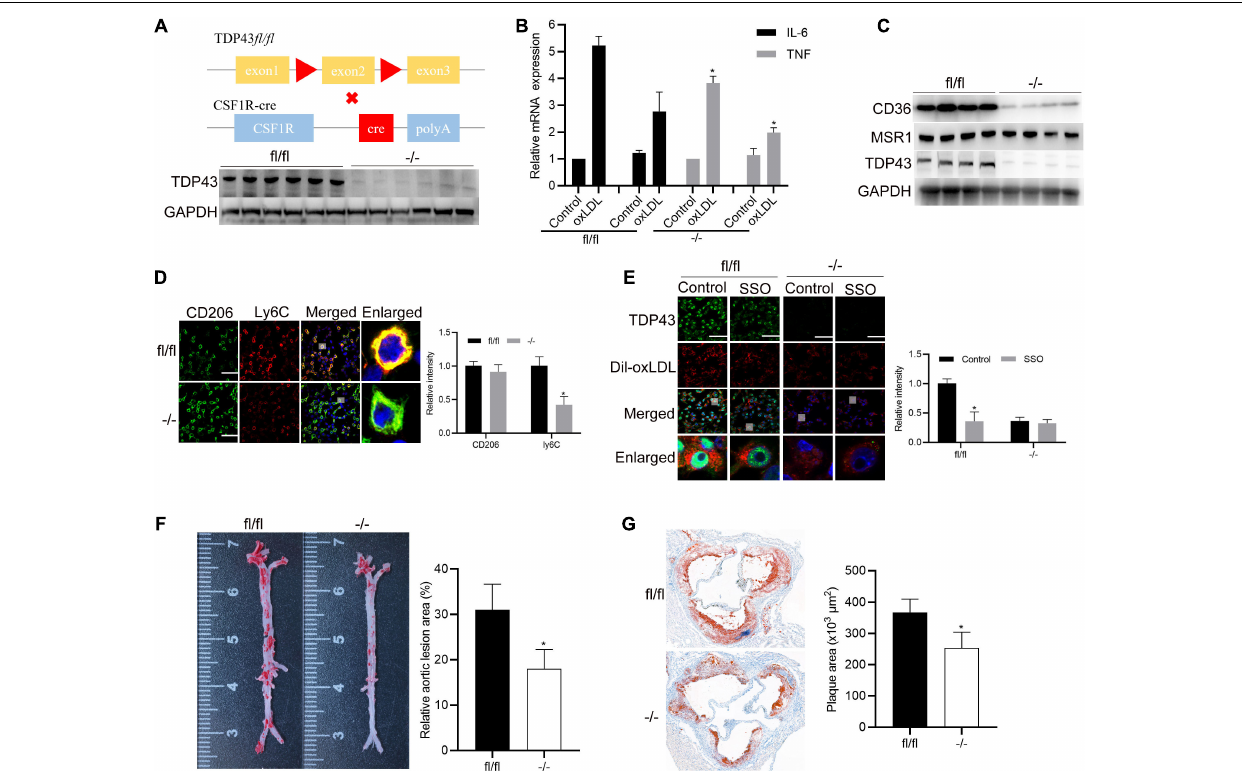
FIGURE 7 | Specific knockout of TDP43 in macrophages alleviates AS progression in vivo . (A) Schematic of macrophage specific TDP43 loss-of-function mouse model (upper panel). Western blot analysis TDP43 from thioglycolate-elicited primary peritoneal macrophages extracts from control (fl/fl) or macrophage-specific TDP43 knockout mice (–/–). GAPDH was used as loading control (down panel). (B) qPCR detection of IL-6 and TNF mRNA expressions in thioglycolate-elicited primary peritoneal macrophages from control (fl/fl) or macrophage-specific TDP43 knockout mice (–/–) with or without oxLDL incubation for 24 h. Data are represented as means ± SD ( n = 3; * P < 0.05 vs. oxLDL fl/fl group). (C) Western blot analysis of CD36 and MSR1 protein expressions in thioglycolate-elicited primary peritoneal macrophages from control (fl/fl) or macrophage-specific TDP43 knockout mice (–/–) from western diet-induced atherosclerotic model. (D) Immunofluorescence analysis of CD206 and Ly6C in thioglycolate-elicited primary peritoneal macrophages from control (fl/fl) or macrophage-specific TDP43 knockout mice (–/–) from western diet-induced atherosclerotic model. Data are represented as means ± SD ( n = 50; * P < 0.05 vs. fl/fl group). Scale bar = 100 µ m. (E) Immunofluorescence analysis of Dil-oxLDL uptake of thioglycolate-elicited primary peritoneal macrophages from control (fl/fl) or macrophage-specific TDP43 knockout mice (–/–) with or without SSO treatment. Data are represented as means ± SD ( n = 50; * P < 0.05 vs. control fl/fl group). Scale bar = 100 µ m. (F) Representative images and quantification of the aorta en face lesion stained with oil red O ( n = 6 for each group). Data are represented as means ± SD ( n = 6; * P < 0.05 vs. fl/fl group). (G) Representative images and quantification of the aortic root lesion area stained with oil red O ( n = 6 for each group). Data are represented as means ± SD ( n = 6; * P < 0.05 vs. fl/fl